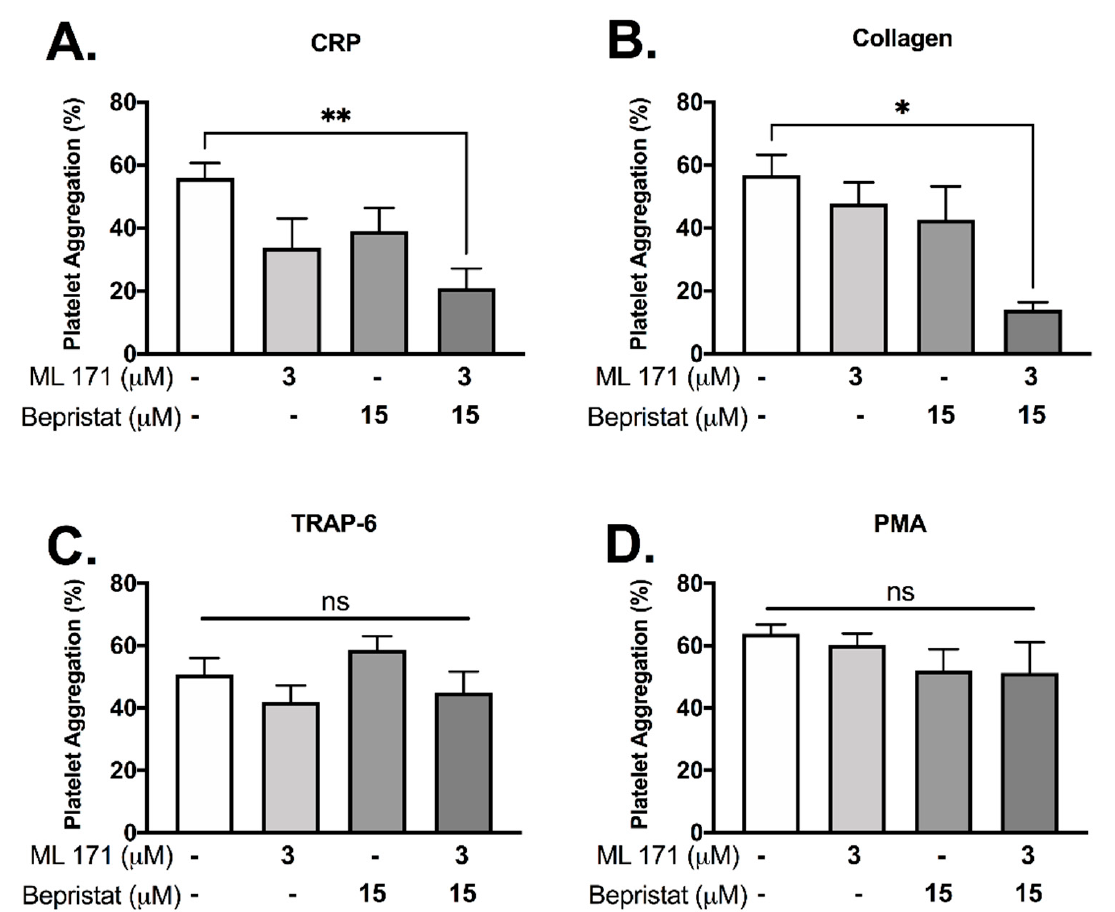
Figure 2. Bepristat and ML171 exert an additive inhibitory effect on plate-based platelet aggregation induced by GPVI agonists. Human WP at 4 × 10 8 platelets/mL were pre-treated with 3 µ M ML171 and/or 15 µ M Bepristat for 10 min prior to addition of agonists: 1 µ g/mL CRP ( A ), 2 µ g/mL Collagen ( B ), 10 µ M TRAP-6 ( C ) or 500 nM PMA ( D ) ( n = 4–5). Platelet aggregation was measured using a plate-based assay. Data on graphs show mean ± SEM. Data analysed by paired one-way ANOVA and Tukey’s multiple comparisons test. * p < 0.05 and ** p < 0.01. ns: